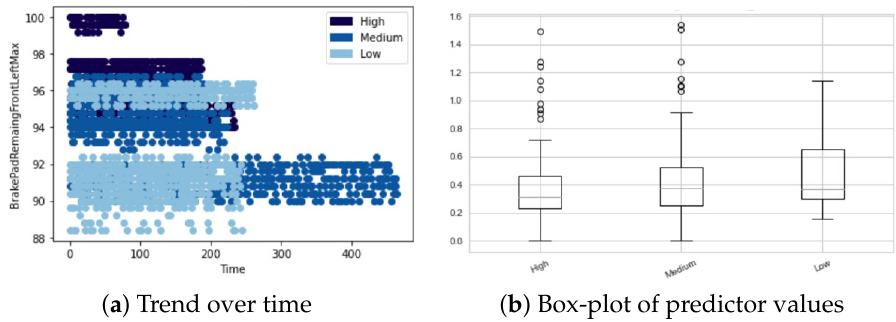
Figure 17. Top predictor: brake pad remaining for different SOH ranges.